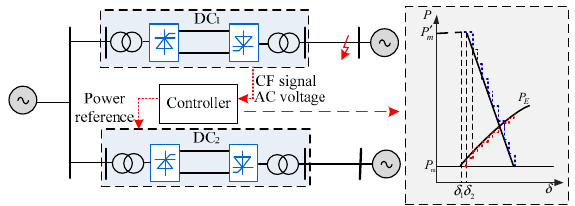
Figure 4. DC emergency power control schematic diagram.